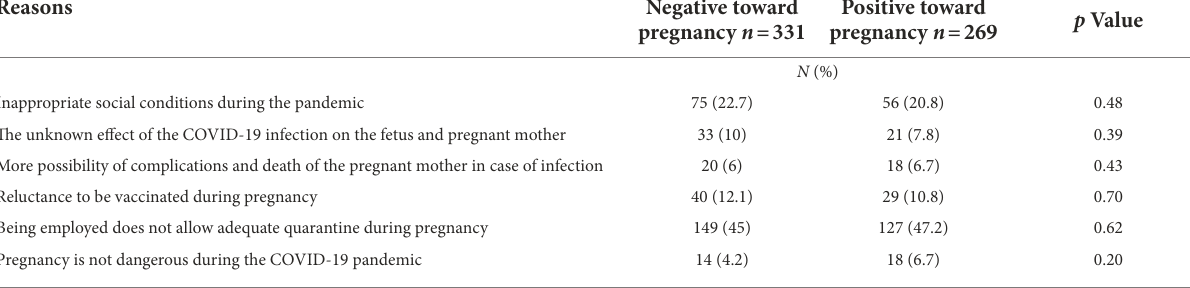
TABLE 4 Logistic regression for assessing the relationship between demographic characteristics and having a positive attitude toward pregnancy and childbearing.